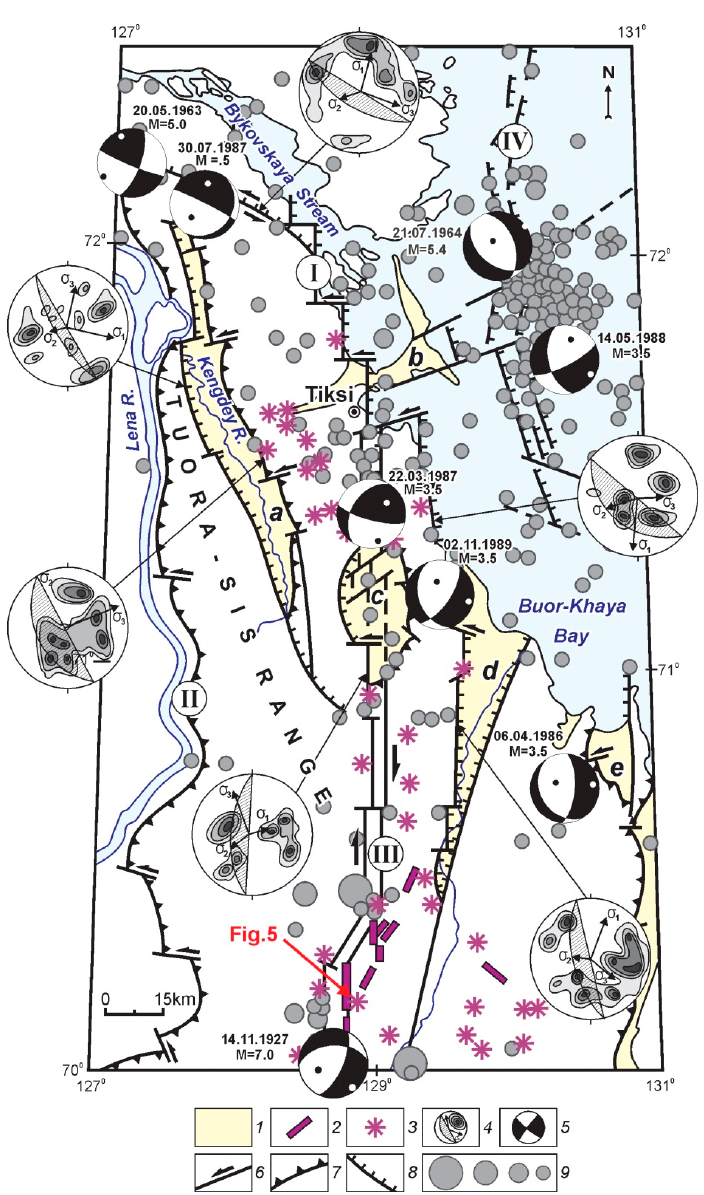
Figure 4. Seismotectonic map of the Kharaulakh segment (modified after [21]). 1—Cenozoic depression: (a) Kengdey, (b) Khorogor, (c) Kunga, (d) Kharaulakh, (e) Nyaybinskaya; 3—locations of seismogravity e ff ects; 4—rock fracturing diagrams, positions of vectors of the principal stress axes and fault planes; 5—focal mechanisms, dates and magnitudes of earthquakes (lower hemisphere; the principal stress axes of compression and extension are marked by black and